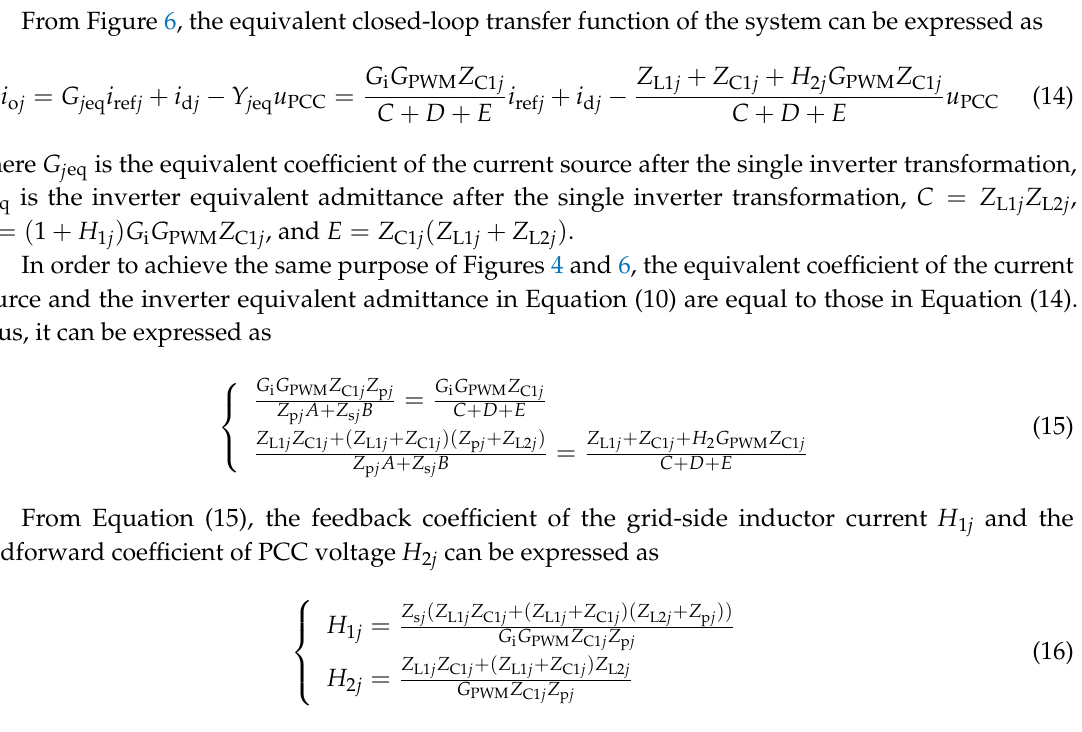
Figure 6. Control block diagram of the oscillation suppression method by two notch filters for parallel inverters.